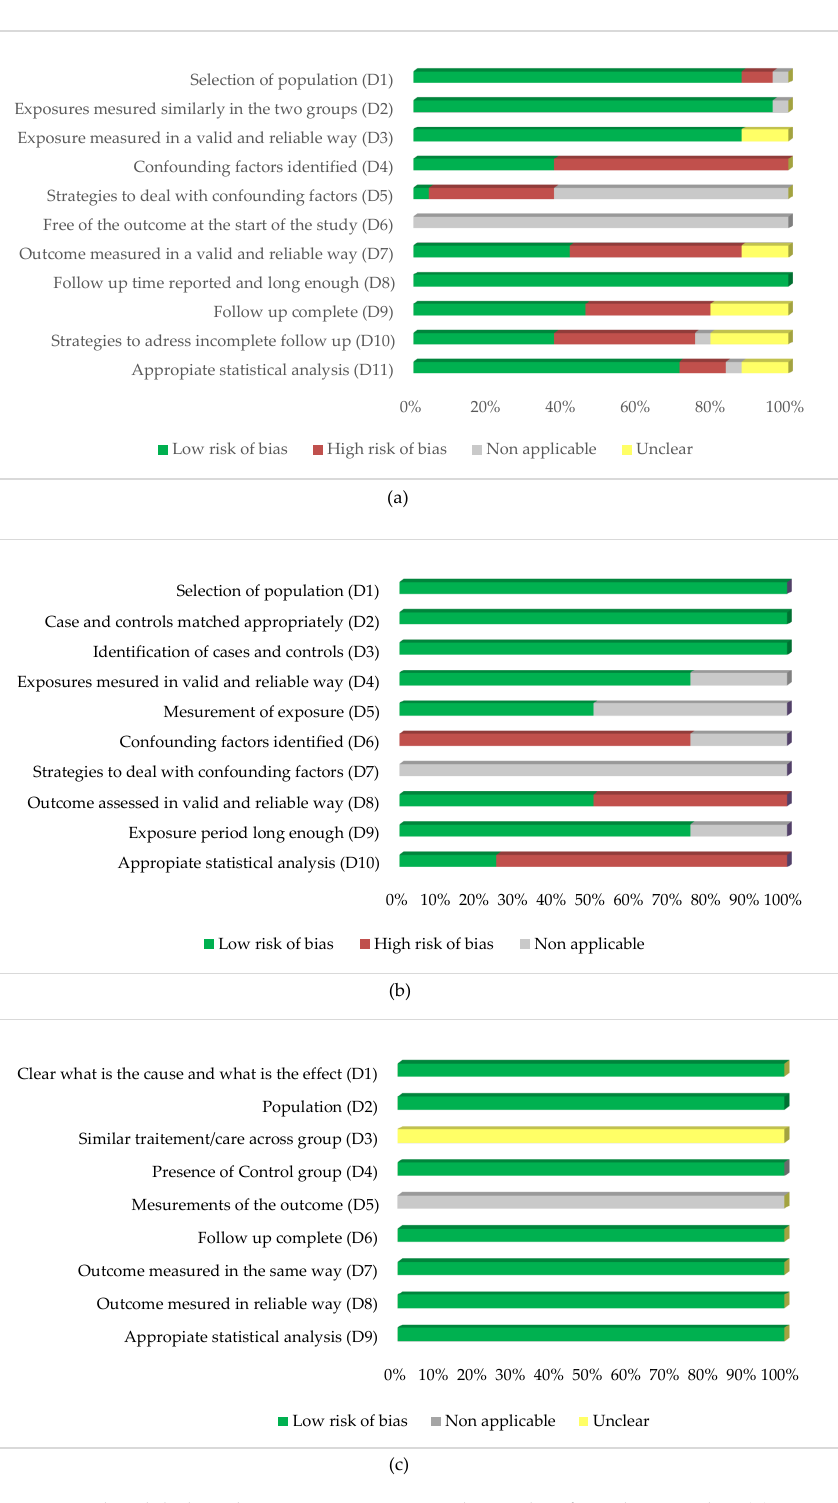
Figure 4. The global quality assessment across the studies for cohort studies ( a ), case-control studies ( b ), and quasi-experimental studies ( c